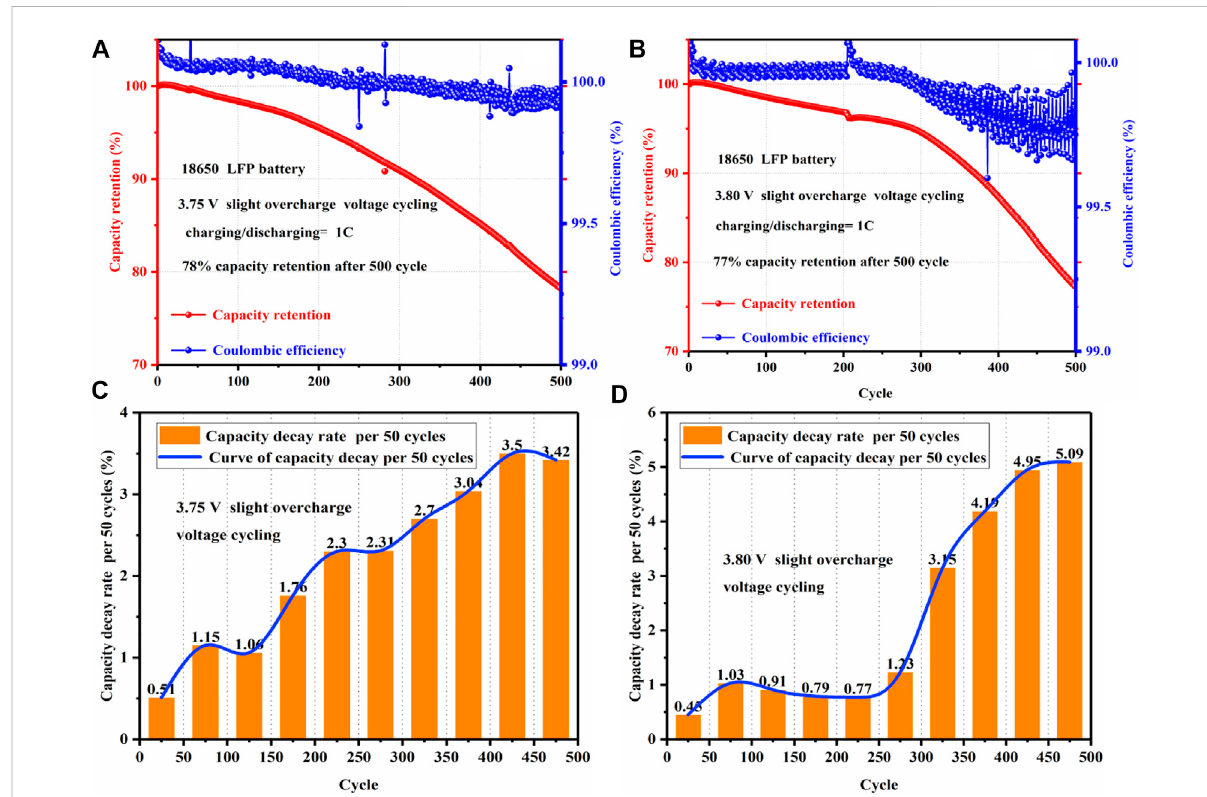
FIGURE 4 (A) Capacity retentionand Coulombic ef fi ciency under 3.75 V slight overcharge voltage, (B) capacity retention and Coulombic ef fi ciency under 3.80 V slight overcharge voltage, (C) capacity decay rate per 50 cycles under 3.75 V slight overcharge voltage, and (D) capacity decay rate per 50 cycles under 3.80 V slight overcharge voltage.